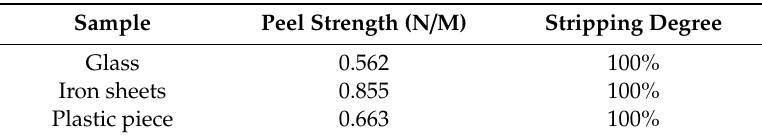
Table 2. Performance test.